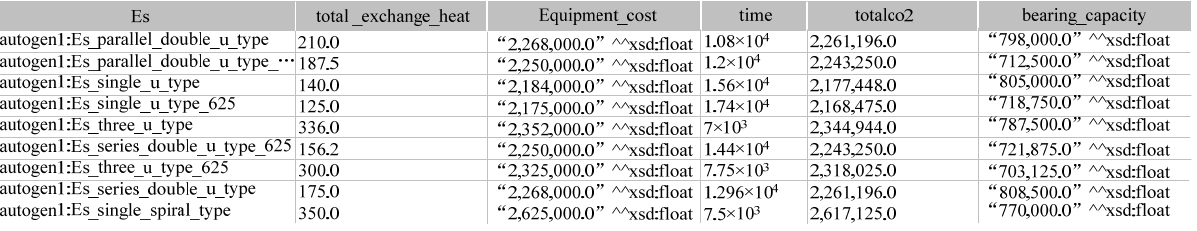
Figure 12. Execution and results of querying R.2 in Table